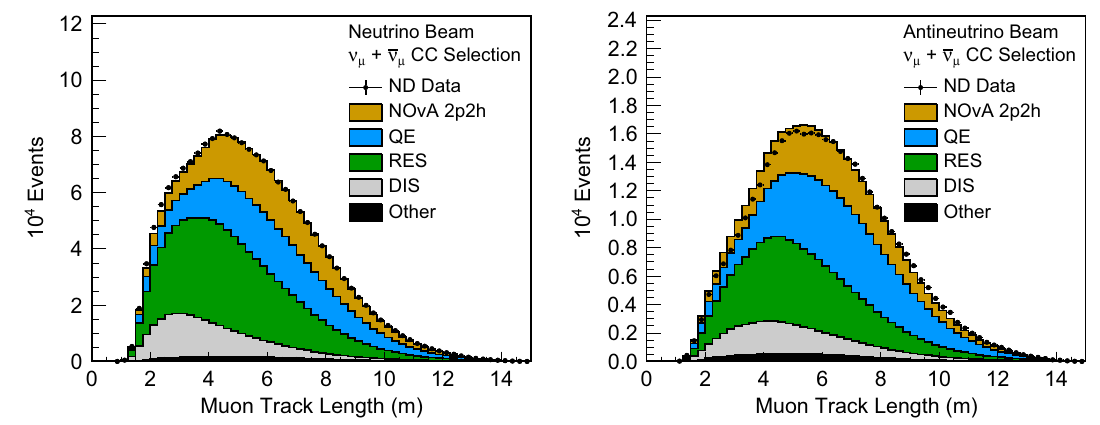
Fig. 14 Comparison of fully adjusted simulation to data in muon candidate track length, for neutrino beam (left) and antineutrino beam (right)